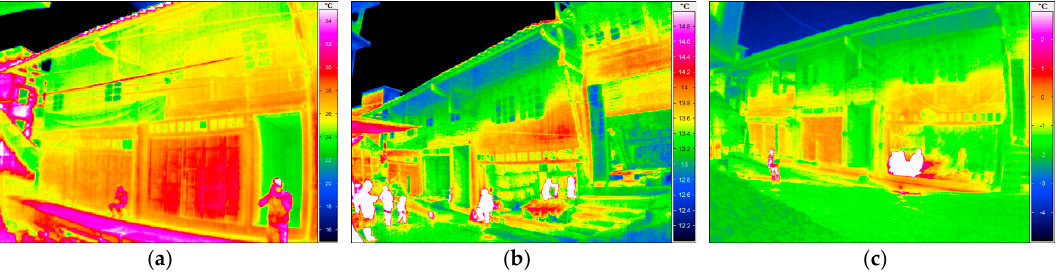
20:00 Figure 19. Thermographs of the timber façade taken in 2014 on: ( a ) February 16th (a cloudy day) and